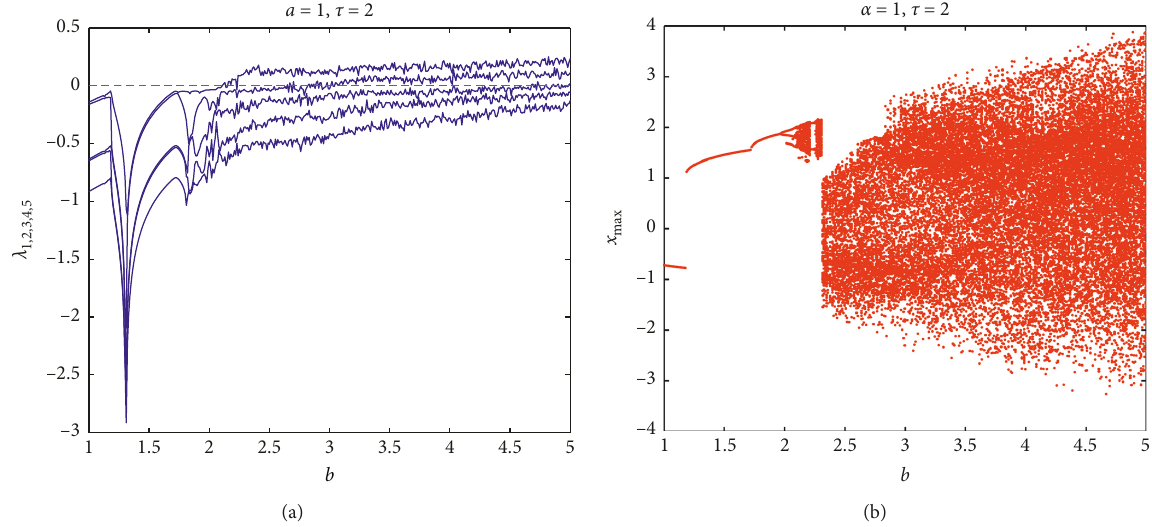
Figure 4: (a) The five largest Lyapunov exponents λ plotted versus the bifurcation parameter 1 ≤ b ≤ 5 for parameter a � 1 and time 1 , 2 , 3 , 4 , 5 delay τ � 2. (b) The bifurcation diagram for the same parameter as in case